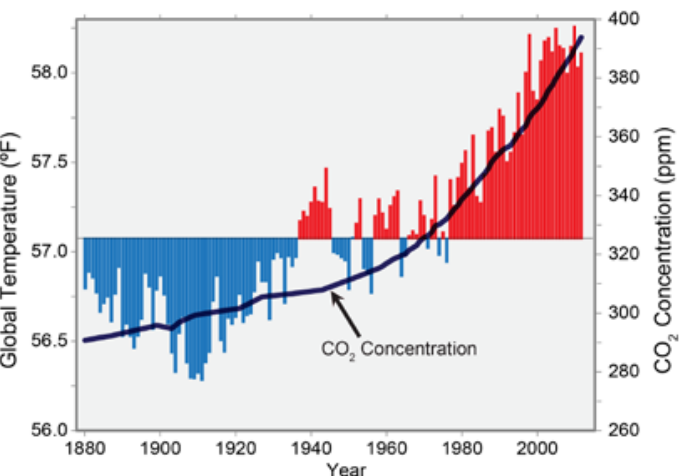
Figure 4. Mean temperature and carbon dioxide concentration in the past 100 years [28].